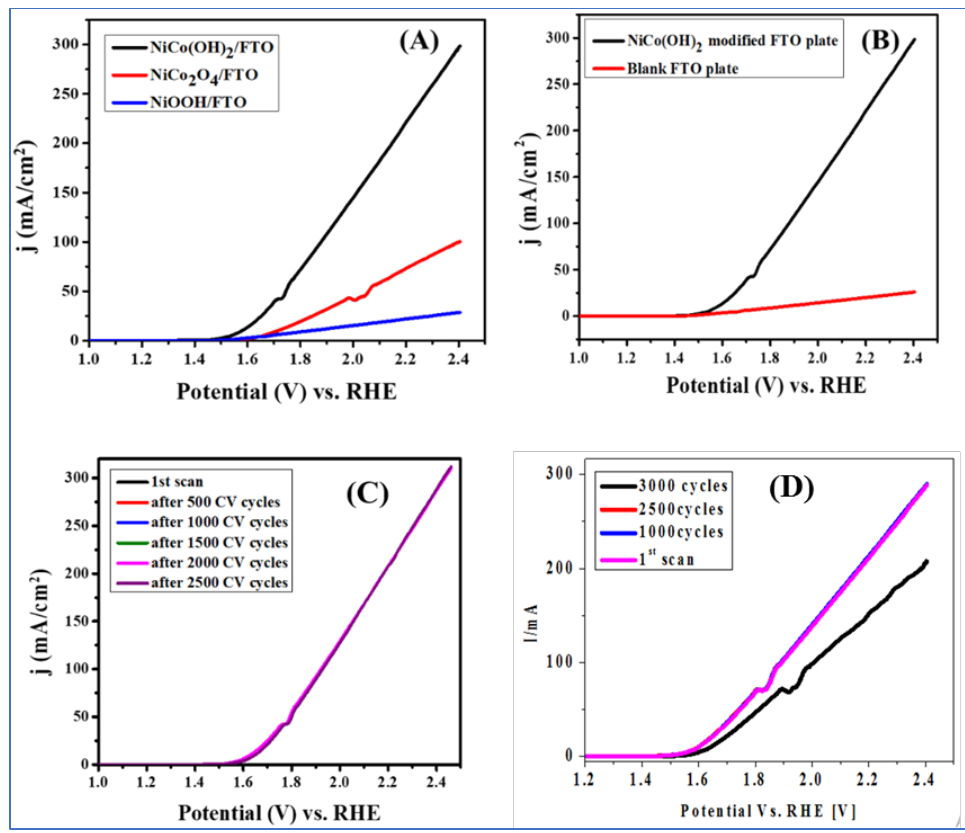
Figure 4. ( A ) LSV curves of NiCo(OH) 2 /FTO, NiCo 2 O 4 /FTO, and NiOOH/FTO; ( B ) LSV of NiCo(OH) 2 /FTO for OER activity in 1 M KOH solution at a scan rate of 10 mV/s; ( C ) LSVs of NiCo(OH) 2 /FTO before and up to repeated 2500 CV cycles; ( D ) LSVs showing current loss after 2500 repeated CV cycles.